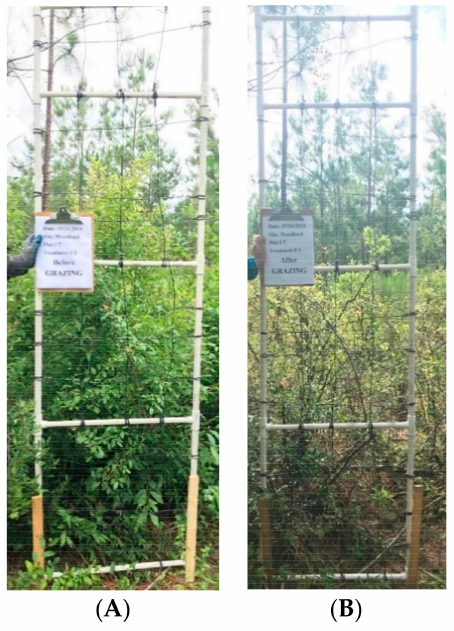
Figure 3. Photoplots taken ( A ) before bringing animals into the study plots to assess the available vegetation and ( B ) after moving animals out of the plots to estimate the vegetation consumed by Kiko wethers and Katahdin rams stocked in woodlands, June–August